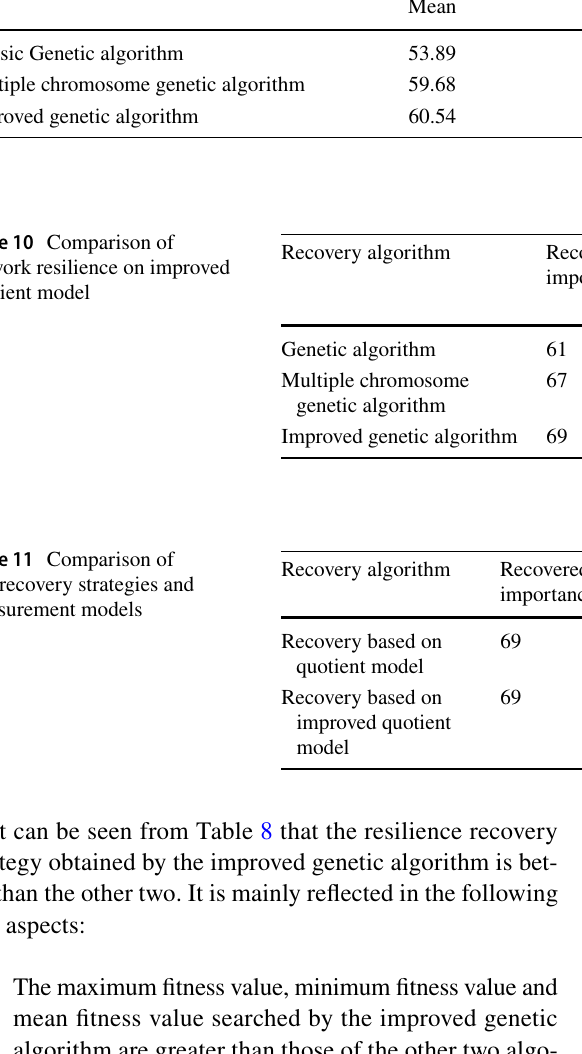
Multiple chromosome genetic algorithm Improved genetic algorithm Table 9 Comparison of algorithm stability on improved quotient model Recovery algorithm